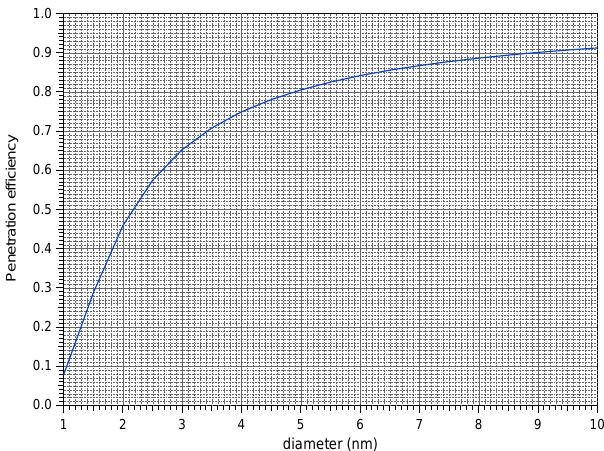
Fig. 8. Calculated penetration efficiencies as a function of size for the experimentally determined parameters (flow rate and tube length). They were derived by measuring the concentrations of size- selected aerosols (3, 4 and 6nm) once after passing a flexible tube and once after passing through an empty laminar flow CPC (model TSI